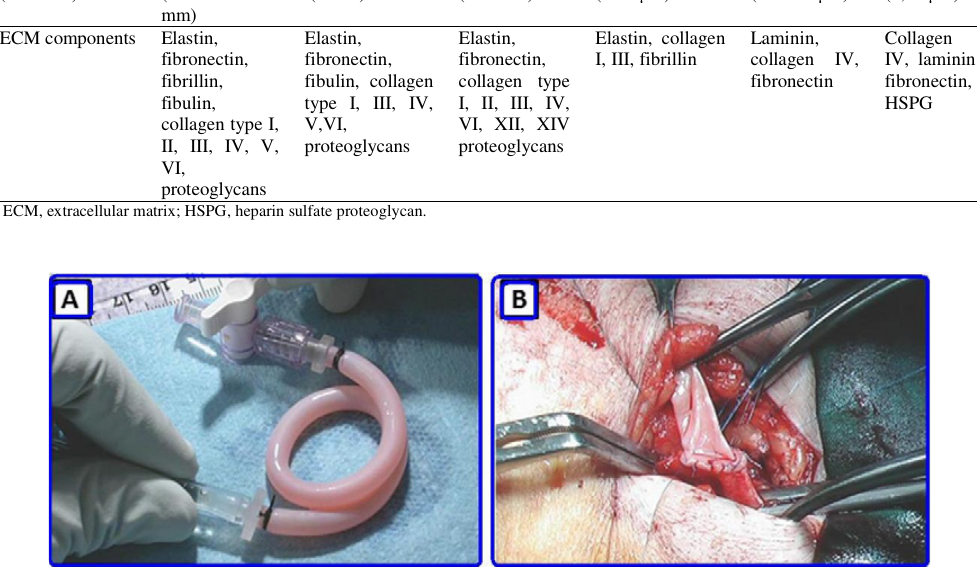
Fig. 2. Tissue engineered blood - vessels: (A) Tissue - engineered graft was implanted among the axillary vein and the humeral artery as Figure 2. Tissue engineered blood ― vessels: (A) Tissue ― engineered graft was implanted among the an arterio - venous shunt, (B) The vessel exhibited normal suturing and surgical handling axillary vein and the humeral artery as an arterio ― venous shunt, (B) The vessel exhibited normal suturing and surgical handling properties [13] .